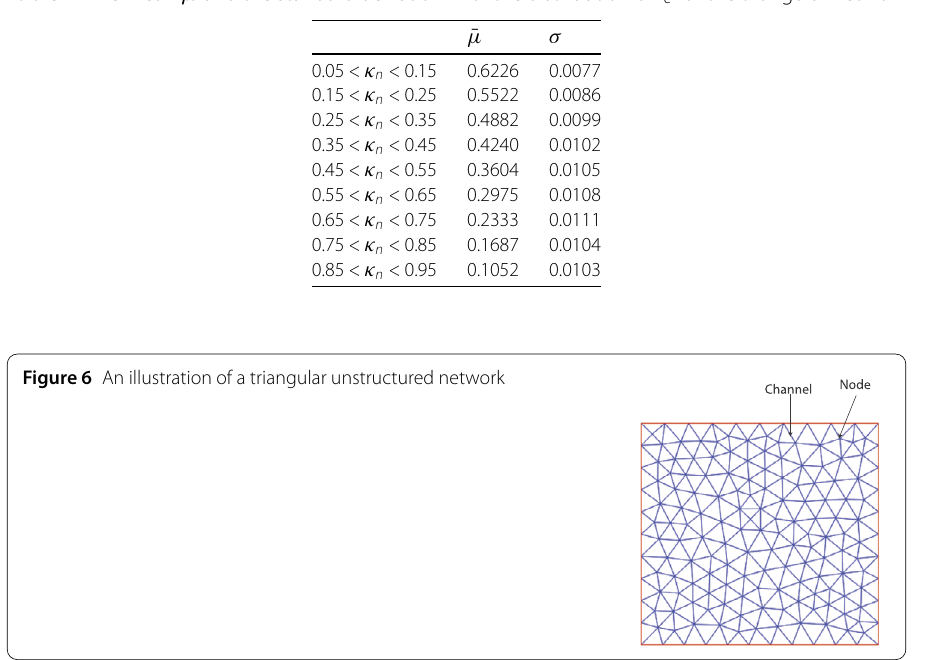
Table 2 The mean ¯ μ and the standard deviation σ of the distribution of f c for the triangular network